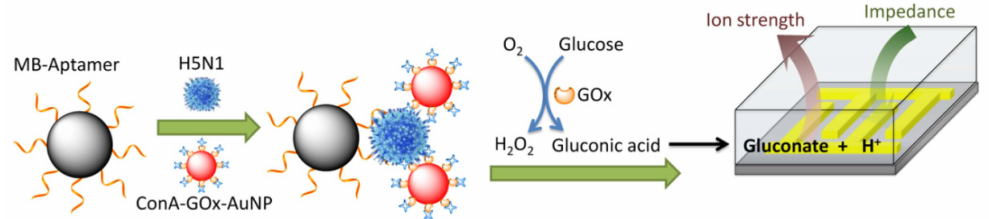
Figure 5. Avian influenza virus sensing based on nano-composites consisting of GOx, Con A, and Au nanoparticles. Reprinted with permission from Analtical Chemistry. Copyright 2014 American Chemical Society